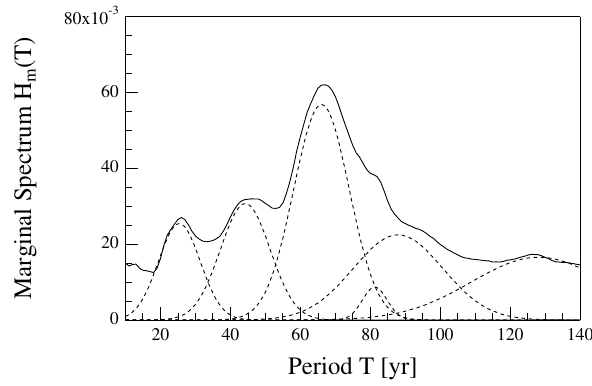
Fig. 8. Marginal spectrum H m ( T ) computed using the ensemble averaged Hilbert spectrum h H ( T,t ) i shown in Figure 6. The dashed lines correspond to the six Gaussian functions (see expression of Eq.11) whose superposition reconstructs the marginal spectrum H m (T ) .